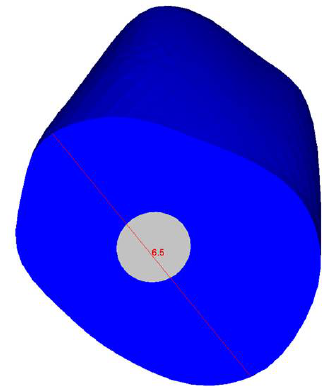
Figure 12. Cross section at the cervical margin of the tooth that was further analyzed.